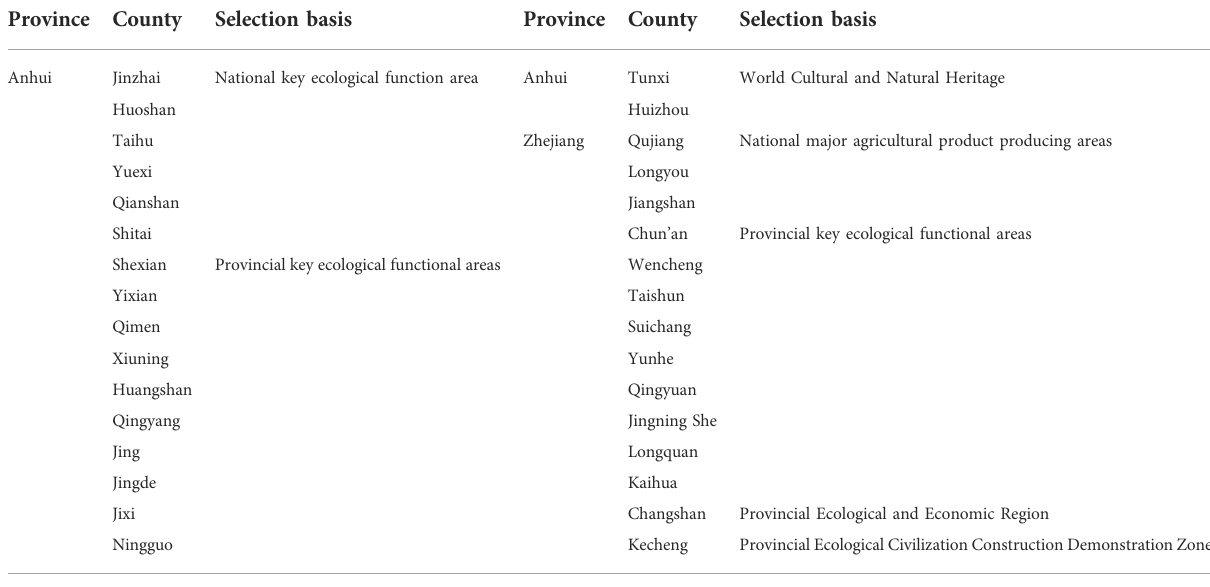
TABLE 1 Selection basis of the study area.